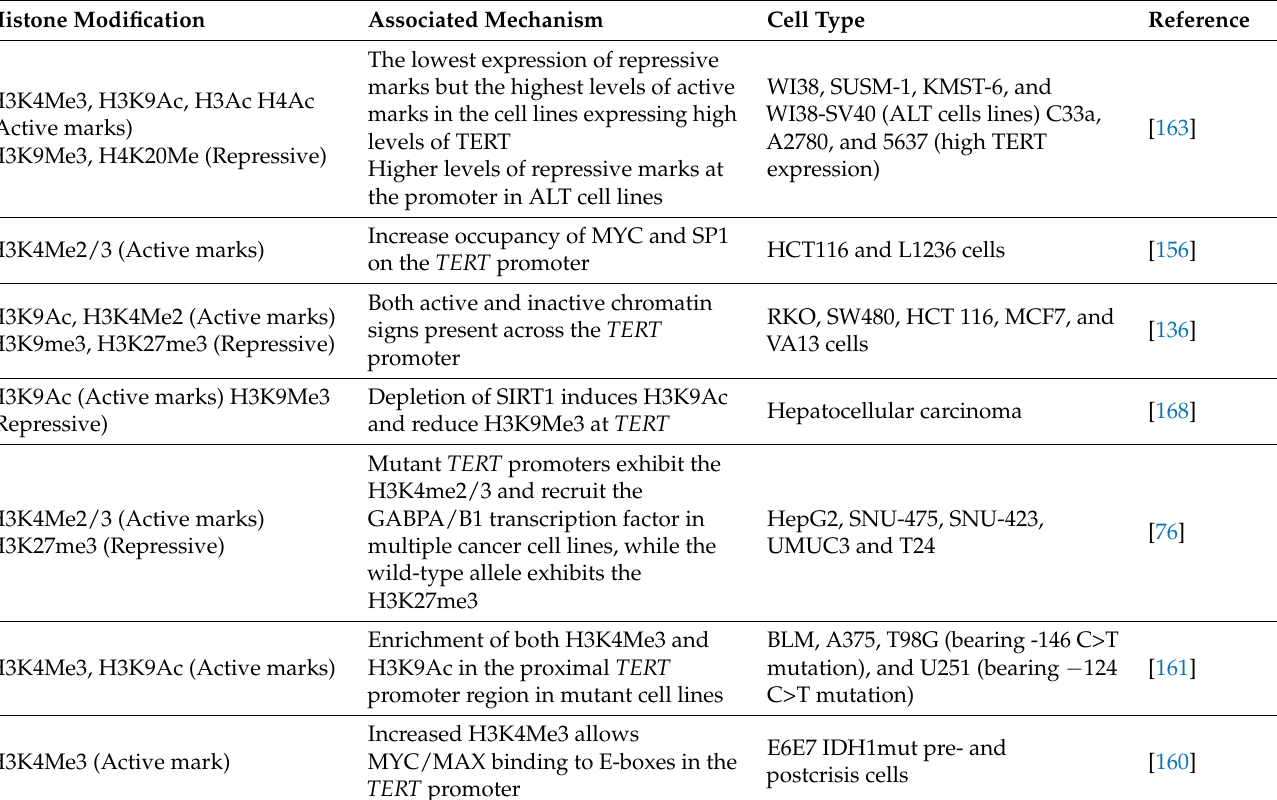
Table 2. Histone modifications of the TERT